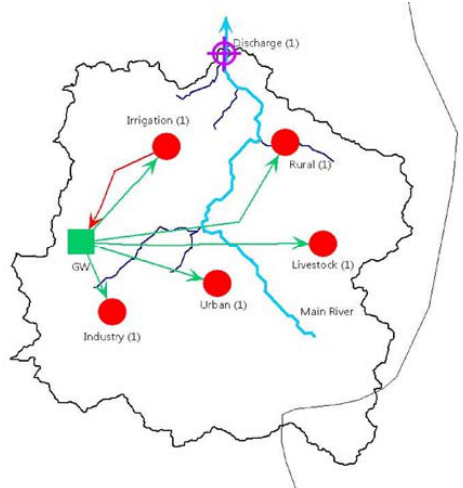
Figure 3. Schematic of the WEAP model for the Klela basin, GW is groundwater. Red points are water demands; the green square is groundwater source, the green and red arrows are the transmission link (which link water sources and sinks); and the symbol is the discharge point of the study area.